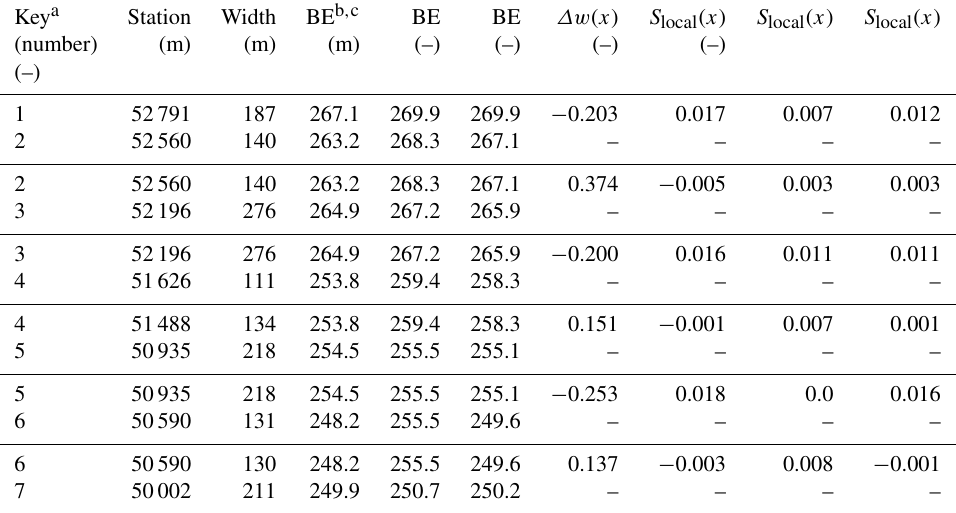
Table B4. Measurement details for Fig. 5 of Brew et al.